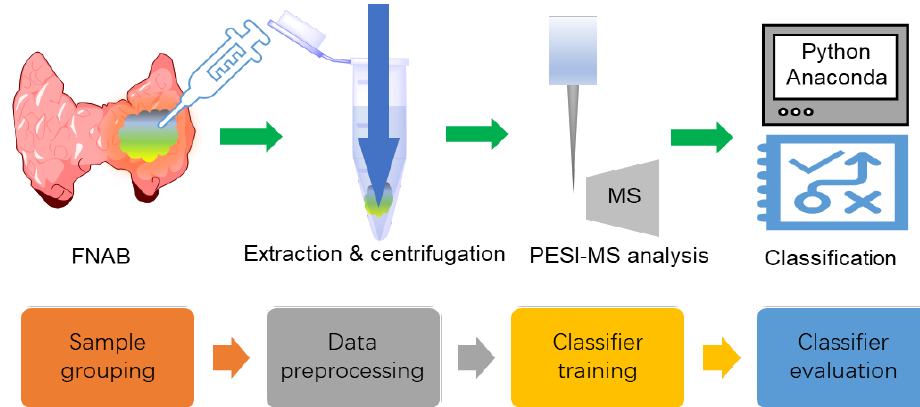
Figure 1. The experimental and machine learning protocols with the FNAB samples.